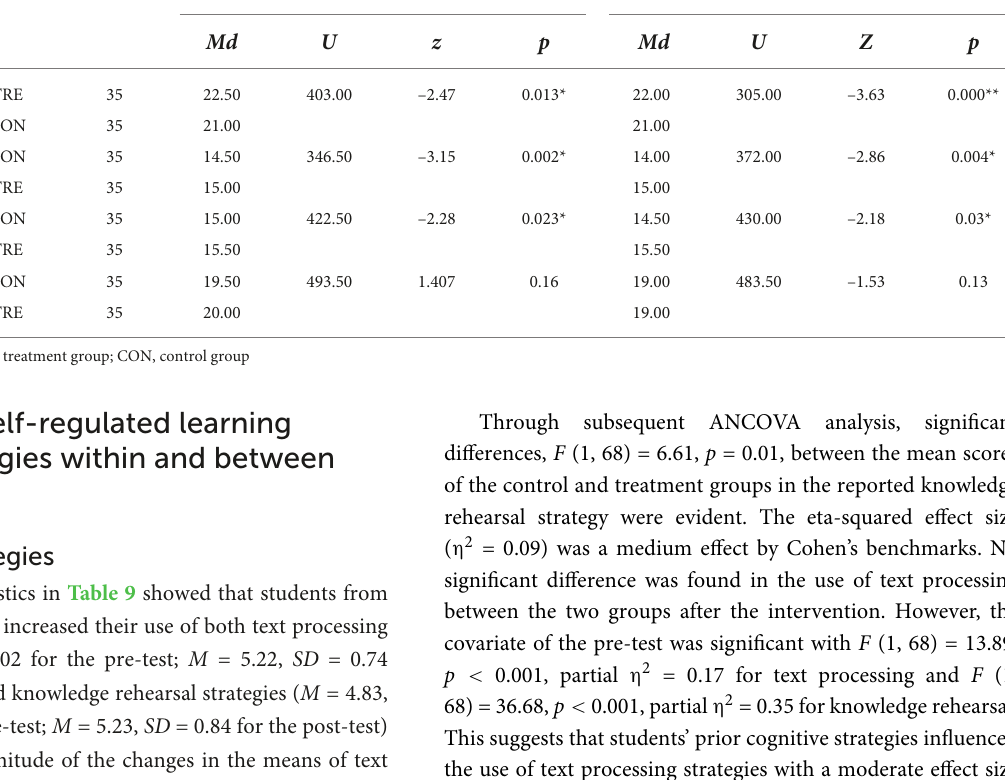
TABLE 8 Descriptive statistics and results of Mann-Whitney U tests of analytic writing scores for the treatment and control groups in the post- and delayed post-tests.